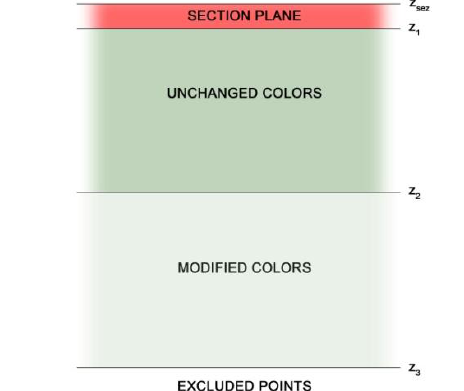
Figure 11. Distance intervals from the section plane; between dz and z 1 the point are represented in real colors, between z 1 and z 2 are represented in modified